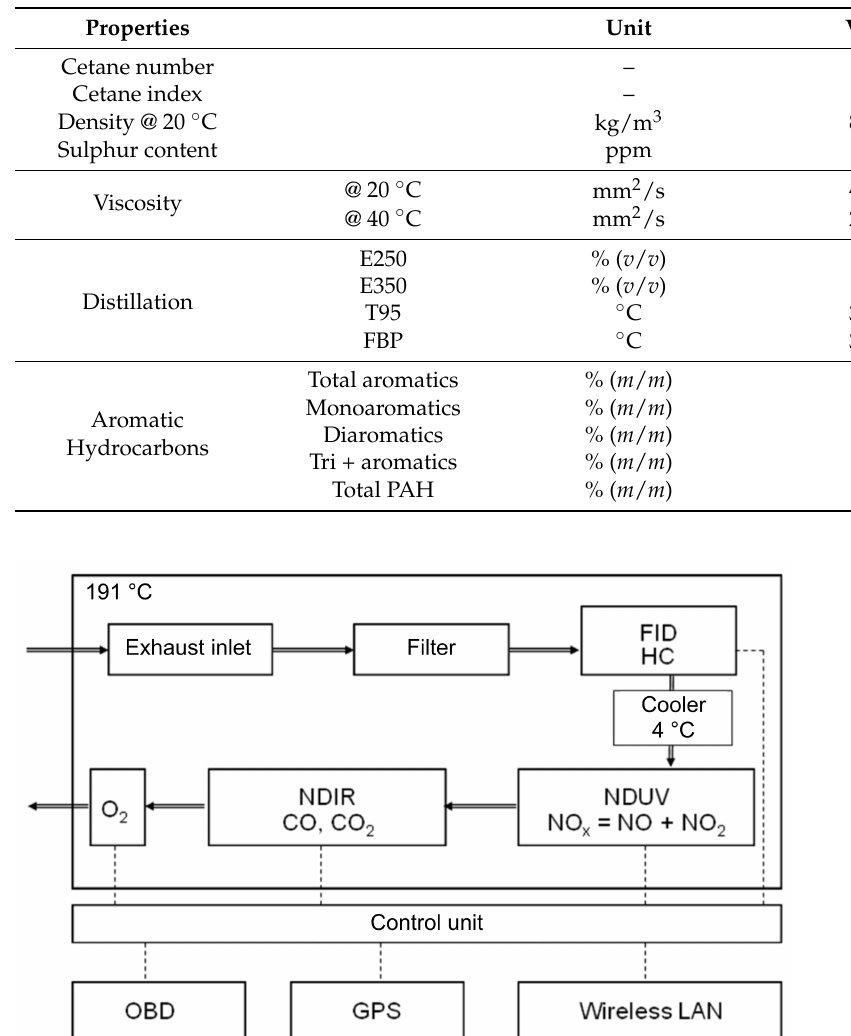
Figure 1. Exhaust gas flow through the SEMTECH DS